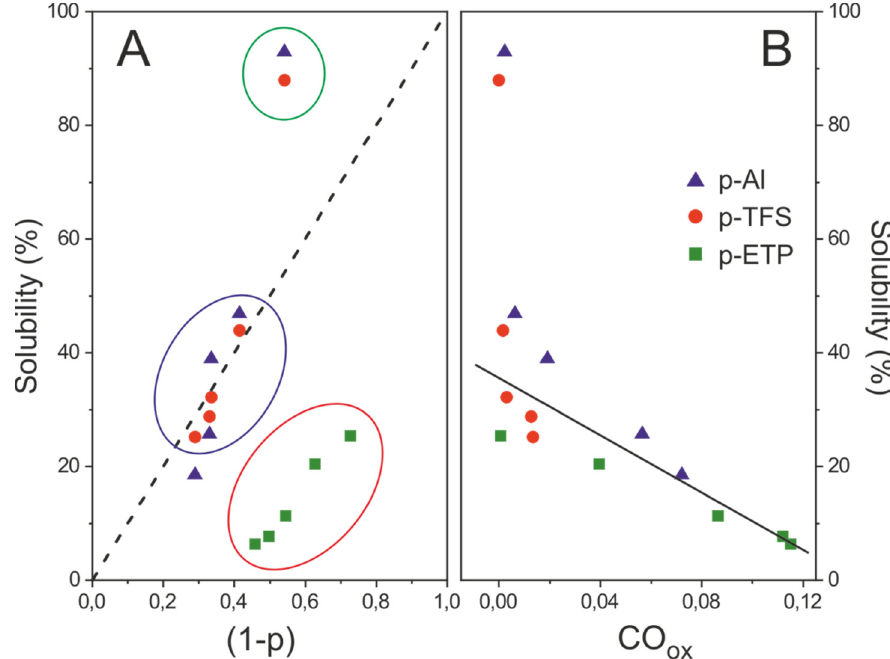
Figure 9. ( A ) Plot of the relative solubility of the polyaleuritate coating vs the fraction of nonesterified aleuritic acid (1 − p). ( B ) Inverse correlation of solubility with the presence of oxidized species formed upon the esterification of aleuritic acid in air. Data correspond to the coatings formed at 200 °C and variable reaction time on the three supports investigated.